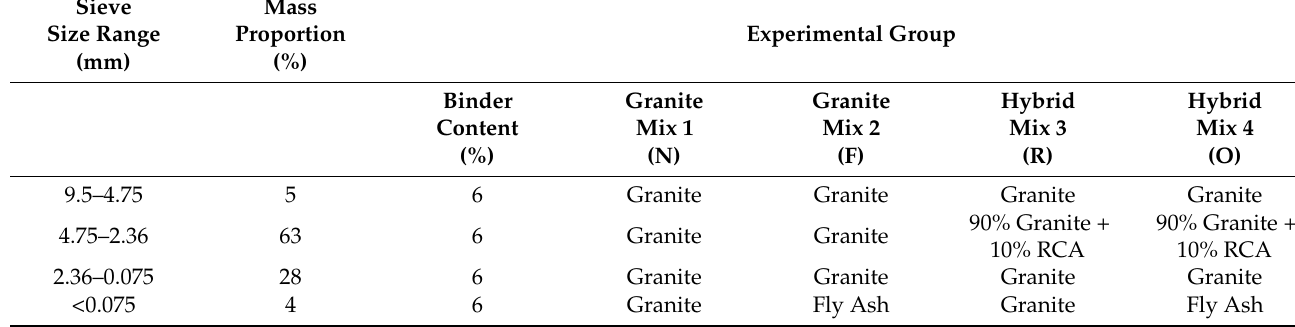
Table 5. PAM designs included in the